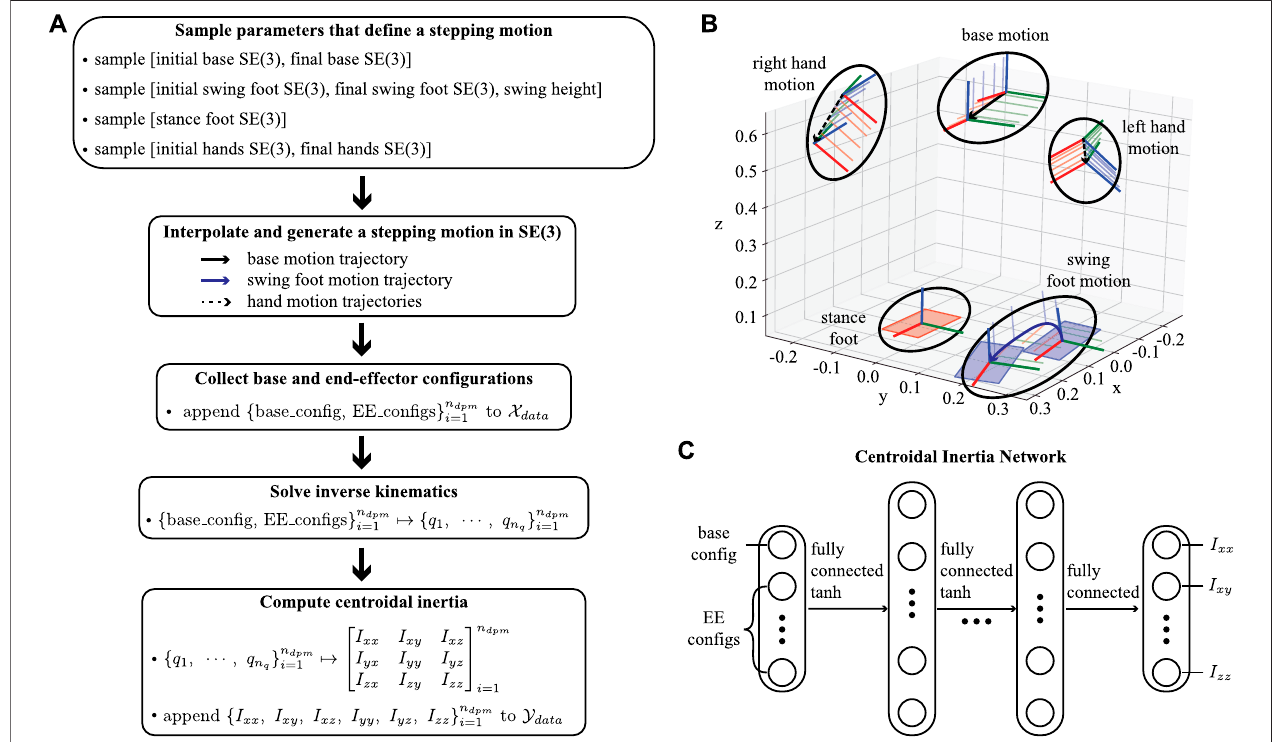
FIGURE4|(A) This fl owchartsummarizesthedatagenerationpipeline. (B) AnexampleofasteppingmotioninCartesianspaceisdepictedwithrandomlysampled initial and fi nal con fi gurations of the base and end-effectors. The sequence of frames for each Cartesian frame depicts our interpolation process, for instance using six samples per trajectory. (C) The centroidal inertia network is composed of a multi-layer perceptron that takes the base and the end-effector con fi guration as inputs and approximates the inertia quantities as an output.